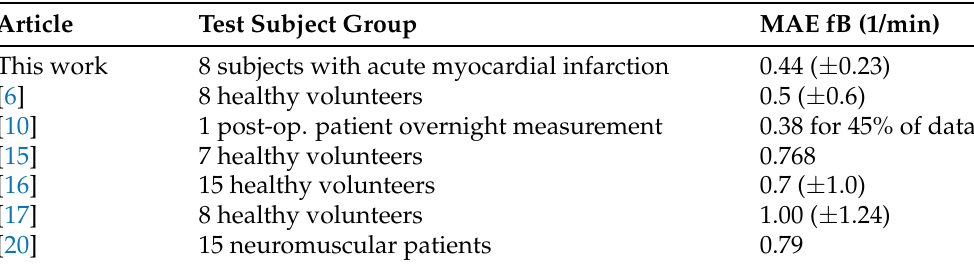
Table 4. Comparison between recent MEMS-based breathing rate estimation methods in terms of the mean absolute breathing rate error per